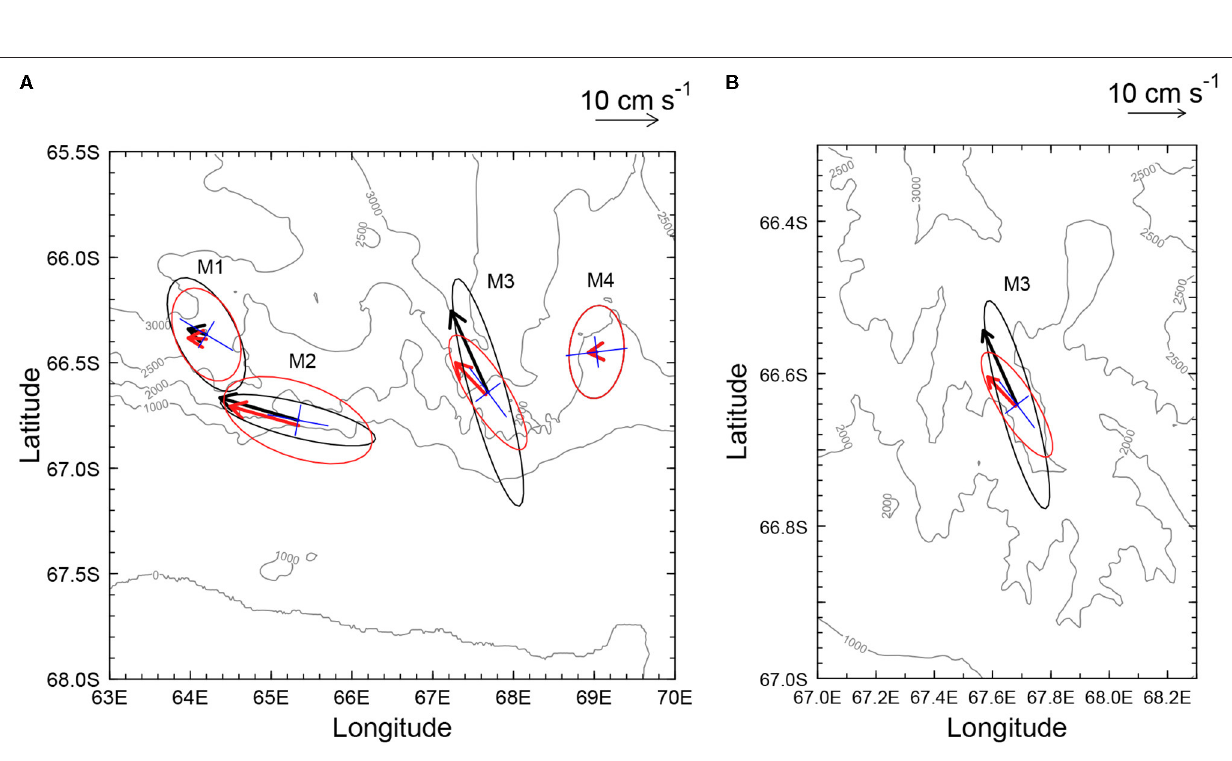
Frontiers in Marine Science | www.frontiersin.org